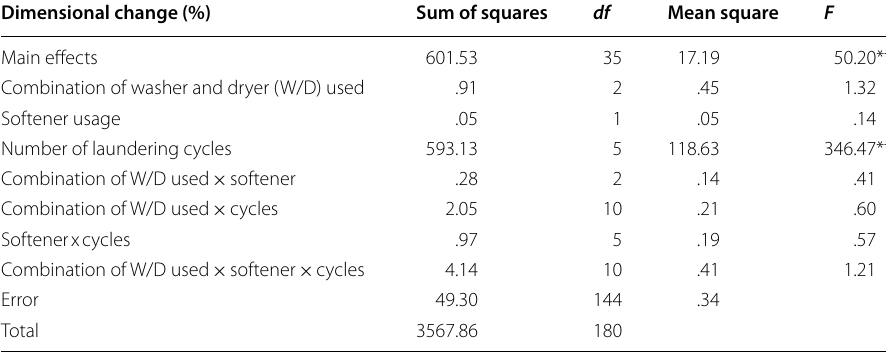
Table 7 Three-way analysis of variance for dimensional change Dimensional change (%) Sum of squares df Mean square F Main effects 601.53 Combination of washer and dryer (W/D) used .91 Number of laundering cycles Combination of W/D used softener .28 × Combination of W/D used cycles × Softener x cycles .97 Combination of W/D used softener cycles × × Total *** p < .001 Table 8 Three-way analysis of variance for skewness change Skewness change (%) Sum of squares df Mean square F Main effects 79.89 Combination of washer and dryer (W/D) used .27 Softener usage .01 Number of laundering cycles Combination of W/D used softener × Combination of W/D used cycles × Softener cycles × Combination of W/D used softener cycles × ×